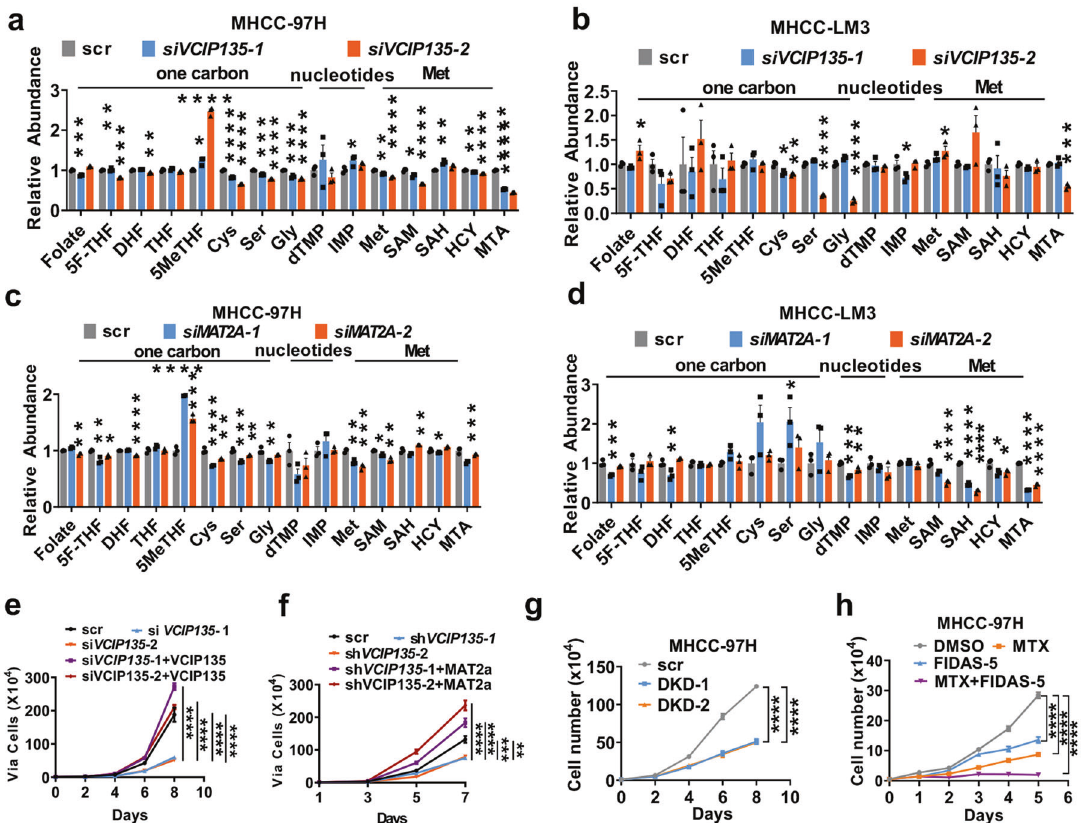
different metabolites of MAT2A knockdown in MHCC-97H cells ( c ) and MHCC-LM3 cells ( d ). Mean ± s.e.m. of n = 3 biologically independent experiments, one-way ANOVA test. e VCIP135 putback recovers VCIP135 knockdown-induced reduction of cell proliferation in MHCC-LM3